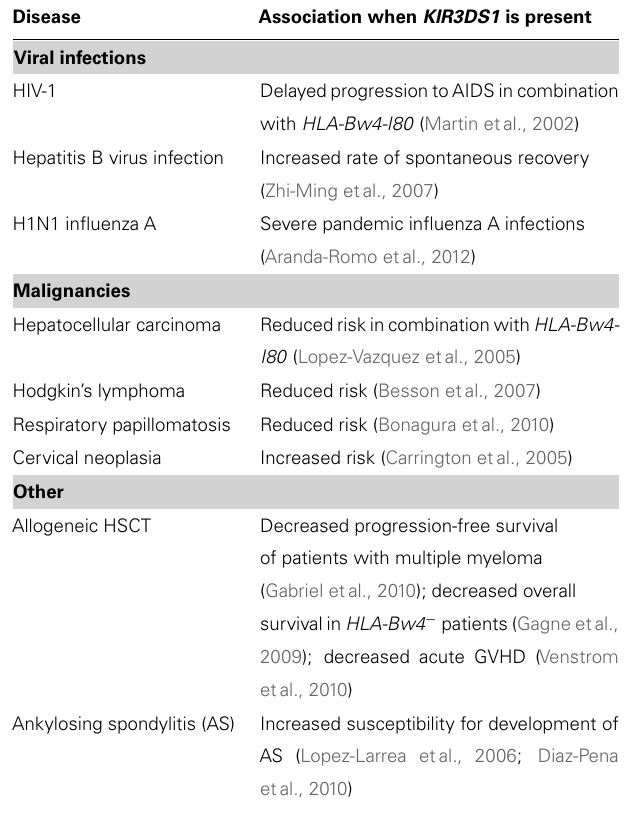
Table 2 | Selected disease associations of KIR3DS1